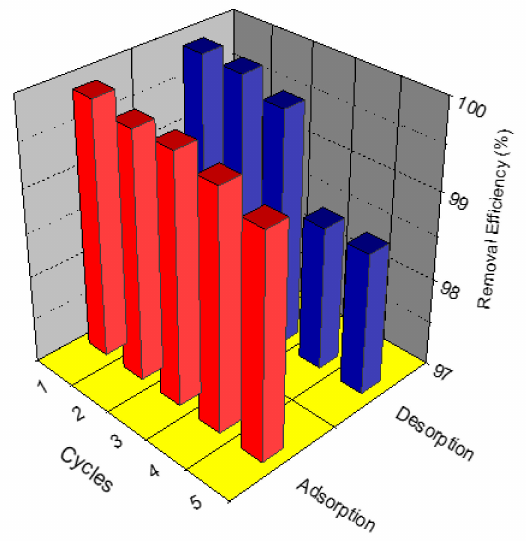
Figure 6. Adsorption–desorption cycles of Garamycin onto MSG. (Conditions: C 0 , 20 mg L − 1 ; adsorbent dose, 2 mg mL − 1 ; and pH, 5.5).